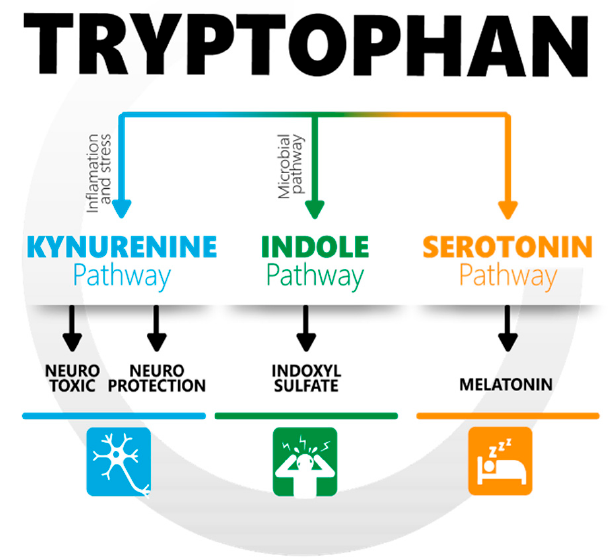
Figure 2. Tryptophan is processed by three different metabolic pathways, depending on the presence or absence of inflammatory process, stress, and actual requirements of the host (own re- sources).